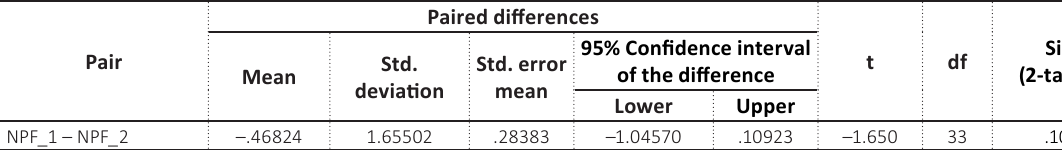
Table A4. Paired samples test (the result of H1b )